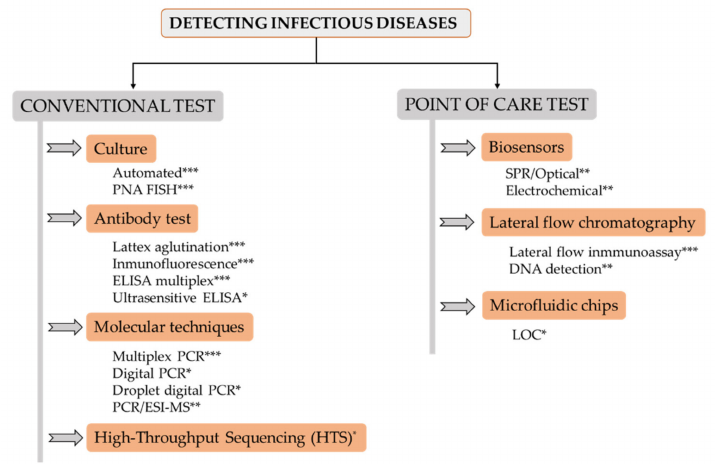
Figure 1. Overview scheme of main pathogen detection systems. Level of implementation in clinical laboratories: * (low); ** (medium); ***